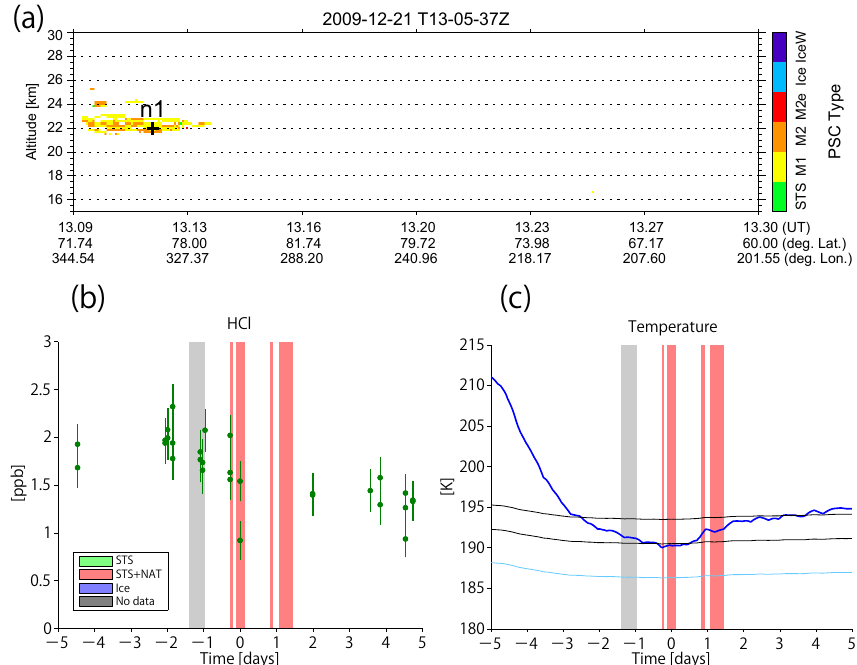
Figure 3. (a) Time–altitude plot of the PSC distribution on 21 December 2009 from 13.09 to 13.3UTC (fractional hours). PSC classifications are color coded (STS, M1: Mix 1, M2: Mix 2, M2e: Mix 2 enhanced, Ice, IceW: Wave Ice; for details see Pitts et al., 2011). The labels on the horizontal axis show fractional time, latitude, and longitude. The cross with “n1” denotes the starting point of the forward/backward trajectories of panels (b) and (c) where Mix 1 PSC was present. (b) HCl measurements by MLS (green dots with error bars) along 5-day forward and 5-day backward trajectories starting at the cross in panel (a) . The match radius between MLS measurements and the trajectory is 200km. The color-coded areas show PSC occurrence measured by CALIOP along the trajectories, with the same color code as in Fig. 2. Time is given relative to the trajectory starting time. (c) Temperature along the trajectories (blue line). The thin black lines show the threshold temperature for NAT formation T NAT and T NAT − 3K. The thin blue line shows T ice